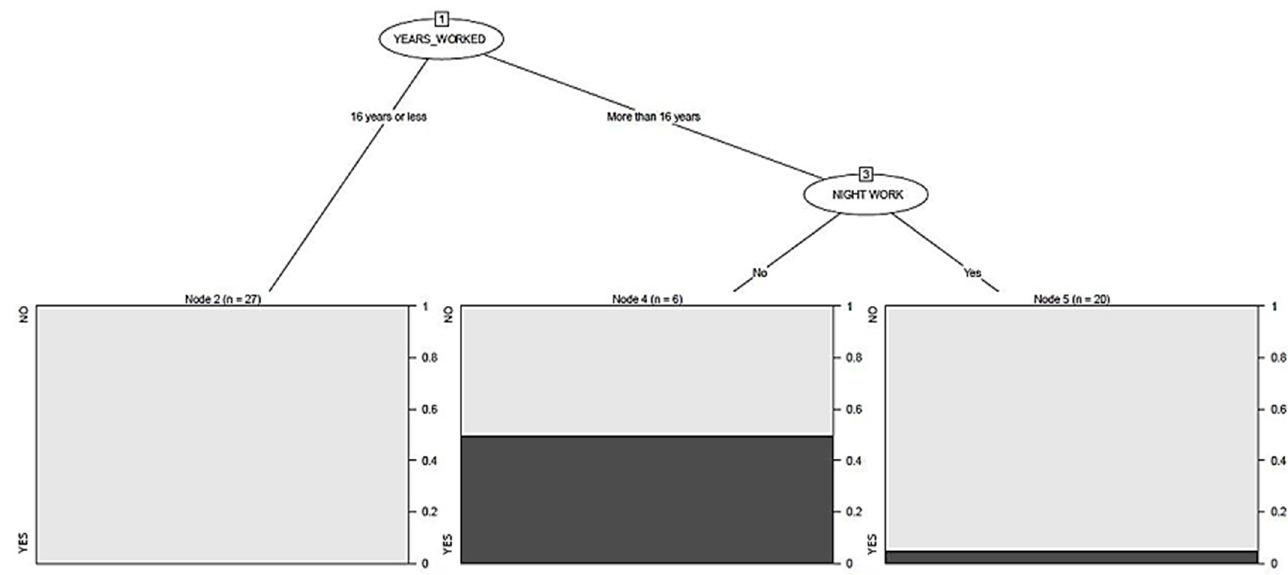
Figure 2. Segmentation tree for male breast cancer.